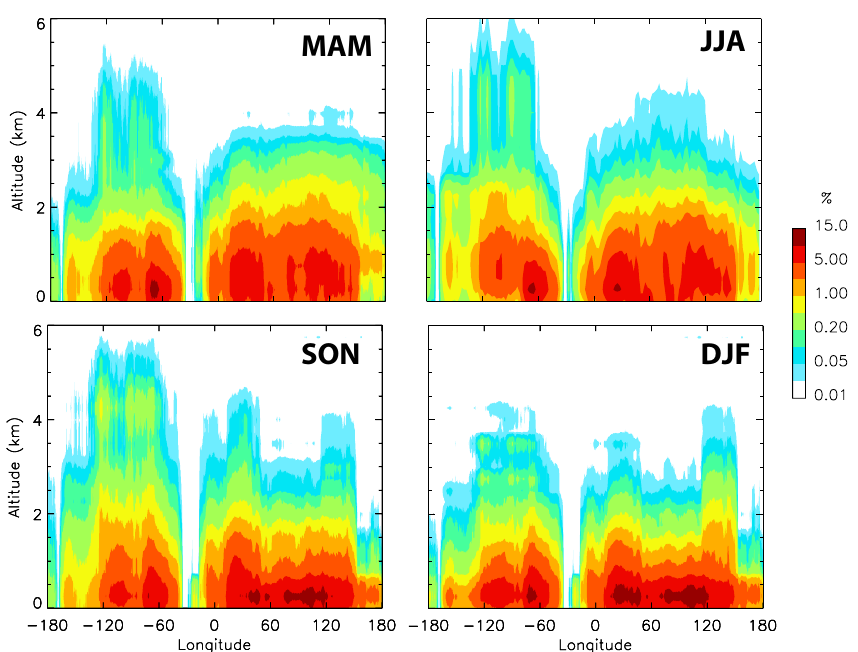
Figure 9. Zonal (80 ◦ S–80 ◦ N) averages of vertical distribution of biomass burning injection heights with the AOD-weighted method (%) for northern spring (MAM), summer (JJA), fall (SON) and winter (DJF). The 2008 data were used for these plots.